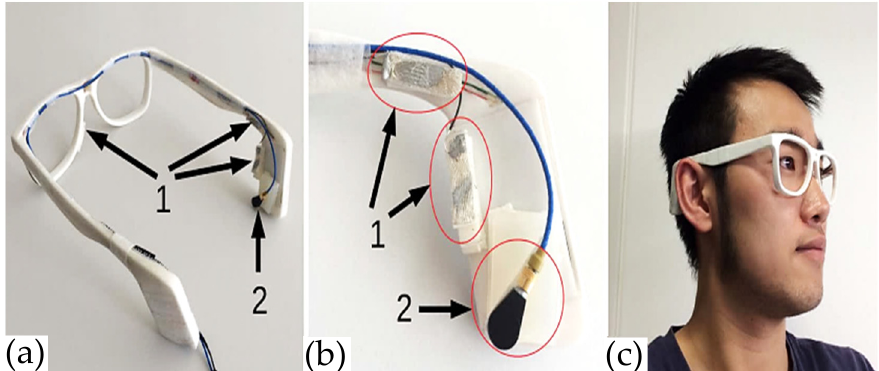
Figure 9. Prototype of the 3D-printed smart glasses, presented in [120] ( a ) with integrated bone vibration sensor and EMG electrodes applied on the right temple ( b ). Smart eyeglasses worn by a user ( c ) (Web-source: https://dl.acm.org/doi/10.1145/2971763.2971799, every aspect related to the human sub-jects’ involvement has been taken into consideration by the authors in [120]) (Image courtsey by the authors, R. Zhang and O. Amft [120]).